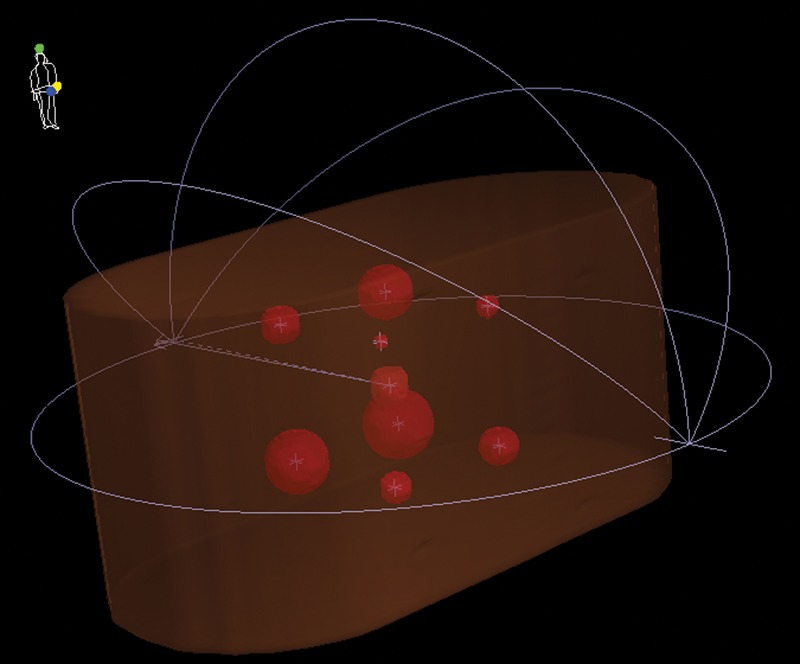
3D phantom view for a single-isocenter nine-target VMAT radiosurgery plan with a full arc and three half arcs. The planned nine targets were spheres with diameters ranging from 5–40 mm and located at the center and eight corners of a virtual cube having a side length of 8 cm, where the cube center and the center of an I'mRT phantom coincided. The linear accelerator isocenter was also positioned at the center of the phantom.